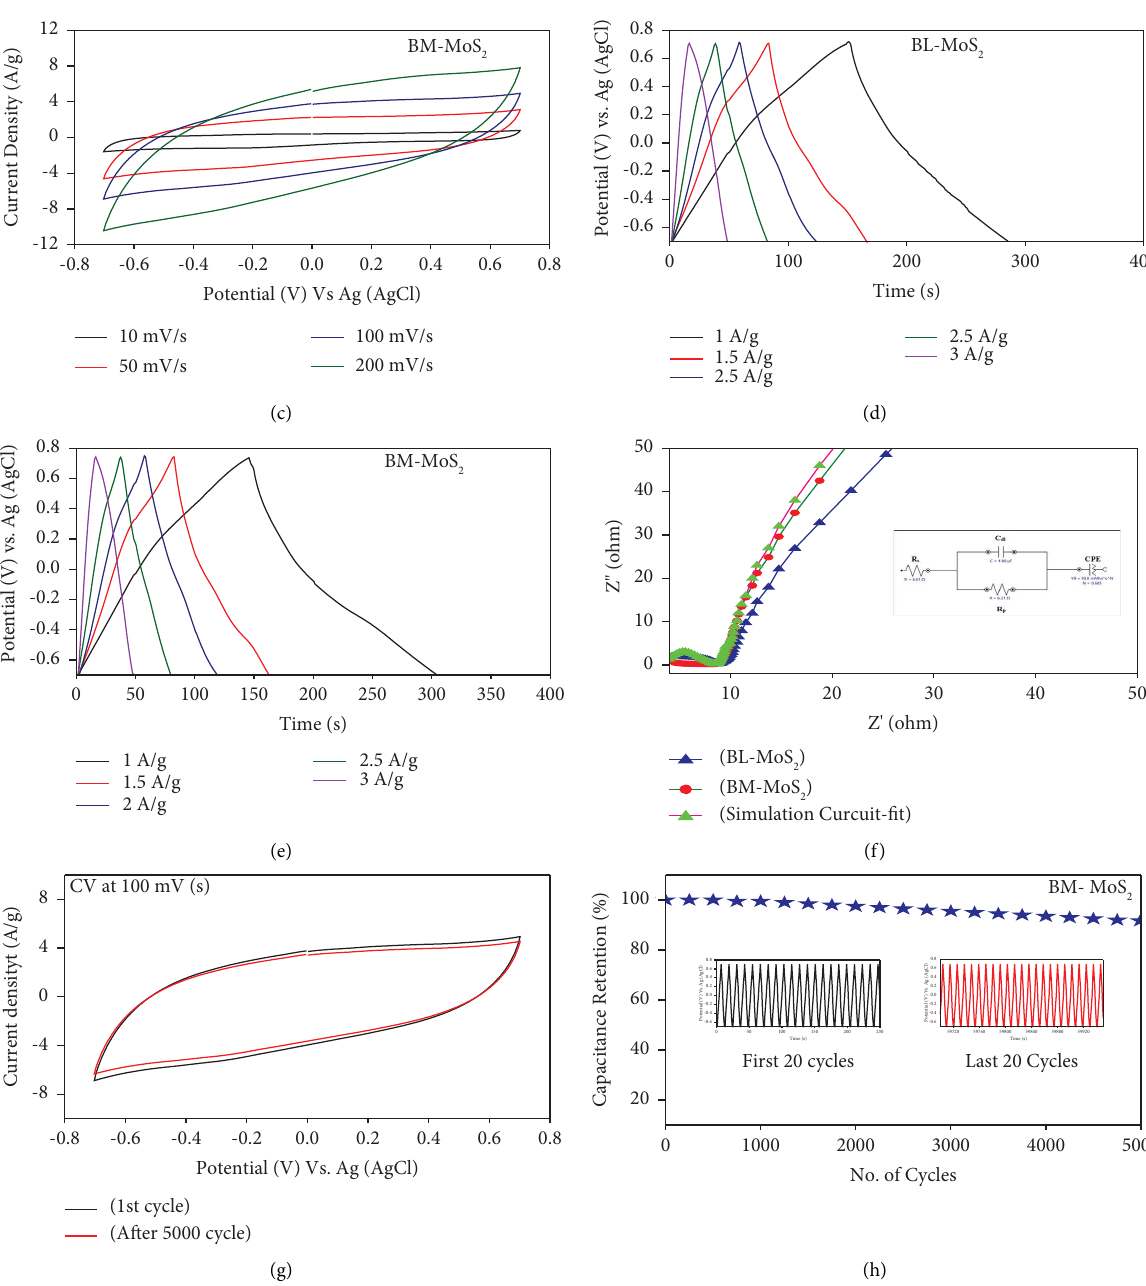
Figure 3: (a) Comparative CV curves of bare graphite sheet, BL-MoS 2 , and BM-MoS 2 at scan rate 100mV/s. (b) CV plot of BL-MoS 2 . (c) CV plot of BM-MoS 2 . (d) GCD profle of BL-MoS 2 at diferent current densities. (e) GCD profle BM-MoS 2 at diferent current densities. (f) EIS spectra of BL-MoS 2 and BM-MoS 2 with an electrochemical circuit ft. (g) Cyclability of BM-MoS 2 at 100mV/s up to 5000 cycles. (h) Capacitance retention of BM-MoS 2 at 10 A/g for 5000